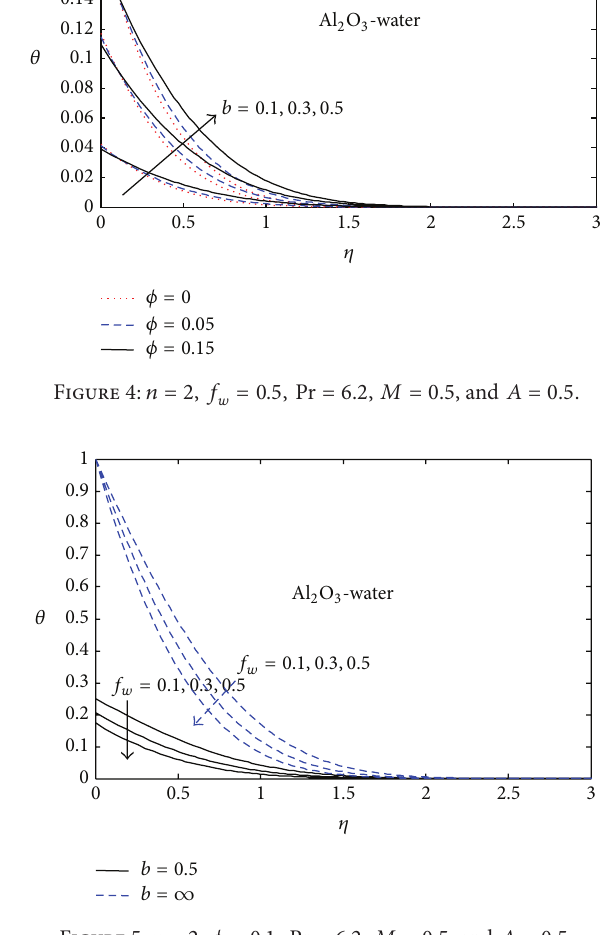
Figure 5: 𝑛 = 2 , 𝜙 = 0.1 , Pr = 6.2 , 𝑀 = 0.5 , and 𝐴 = 0.5 .